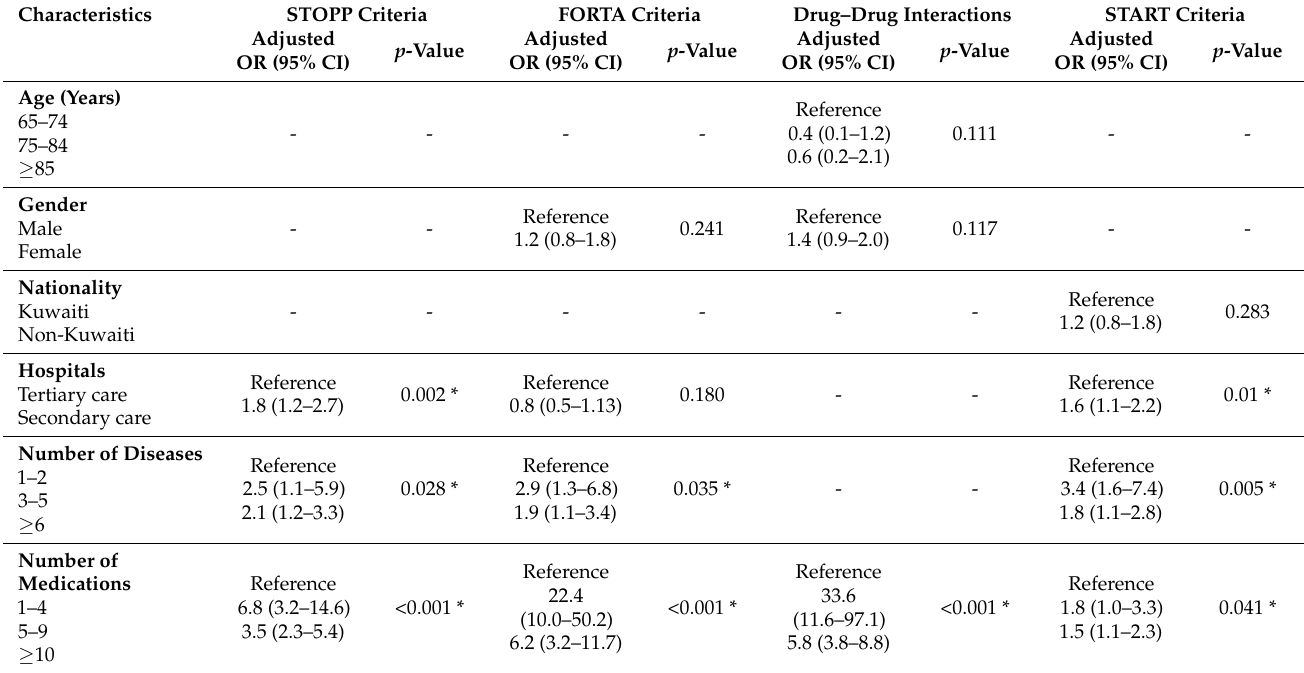
Table 5. Association between patients with PIMs based on STOPP, FORTA, and drug–drug interac- tions, and PPOs based on START criteria, and their